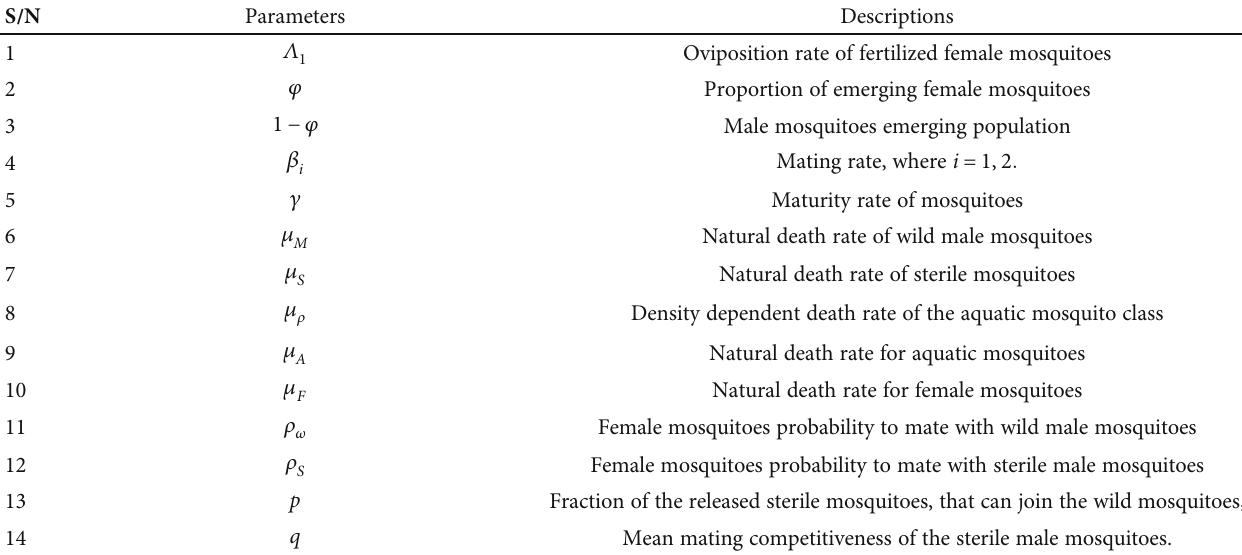
Table 2: Model parameters and